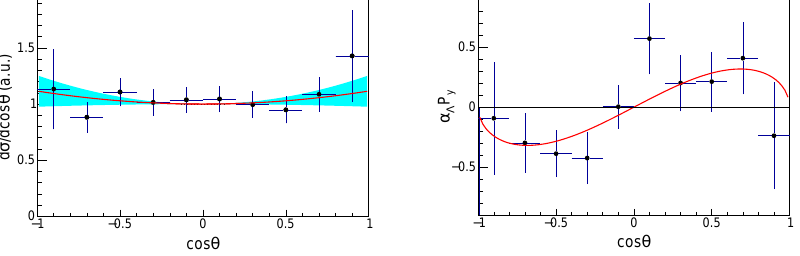
Figure 5. a) The acceptance corrected Λ scattering angle distribution. b) The product of α Λ and Λ polarization P y as a function of the scattering angle.